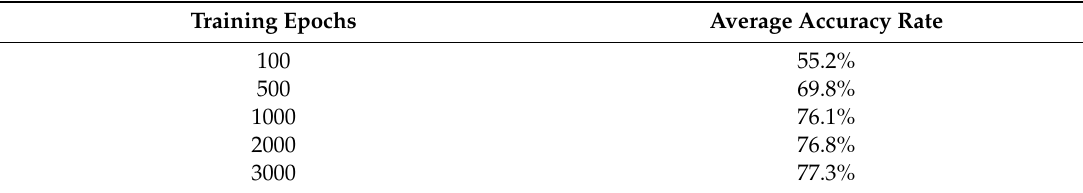
Table 1. Comparison of the accuracy rate with di ff erent training times.